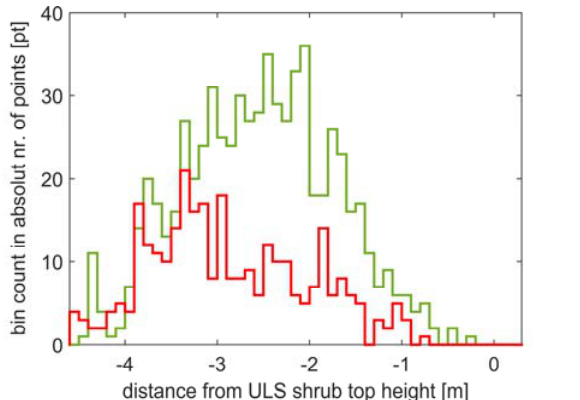
Figure 11. Histogram of 3d points within vegetation column in absolute numbers; the reference zero height is estimated from ULS data; green: ALB; red: